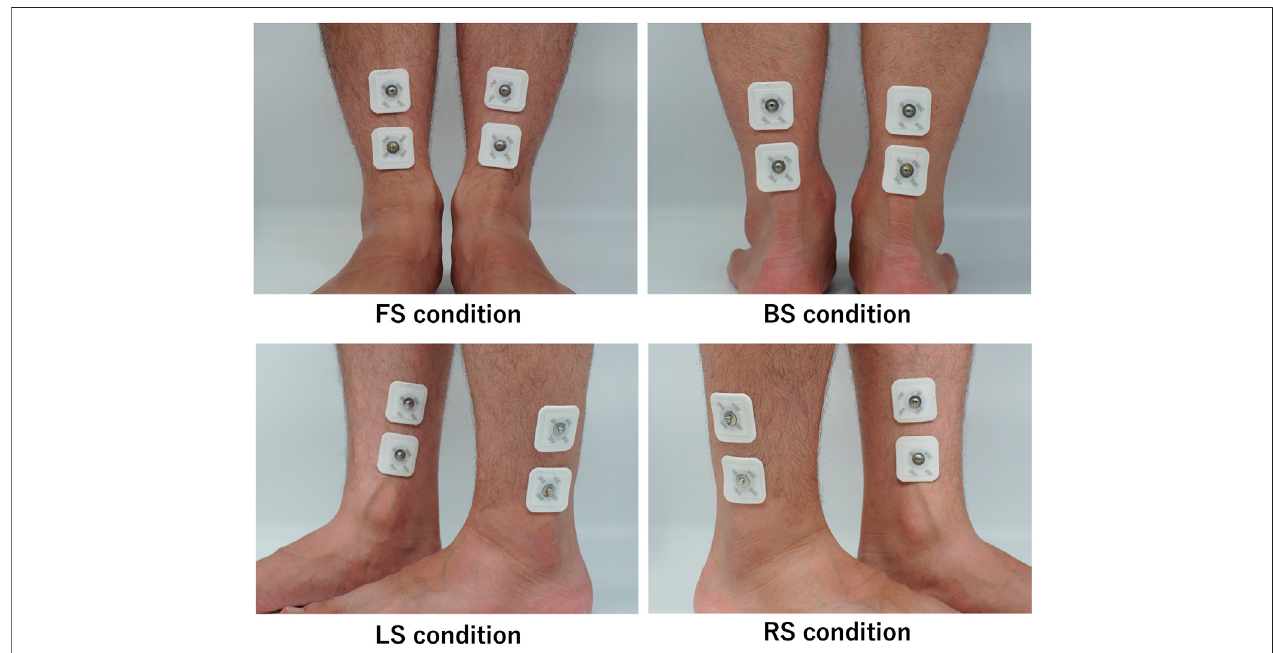
FIGURE 4 | Position of